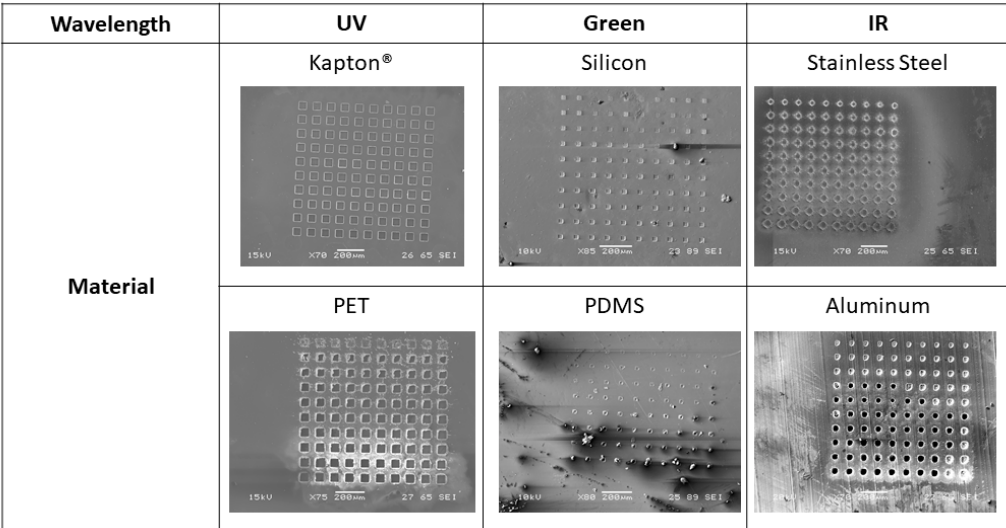
Figure 7. Scanning electron microscope (SEM) images of the laser characterization grids for each of the six materials. Kapton ® , SS, polyethylene terephthalate (PET), and aluminum are all at the maximum spot size for their respective wavelengths. Silicon and polydimethylsiloxane (PDMS) are both at 50% spot size to show the grid in its entirety. All scale bars are 200 µm.